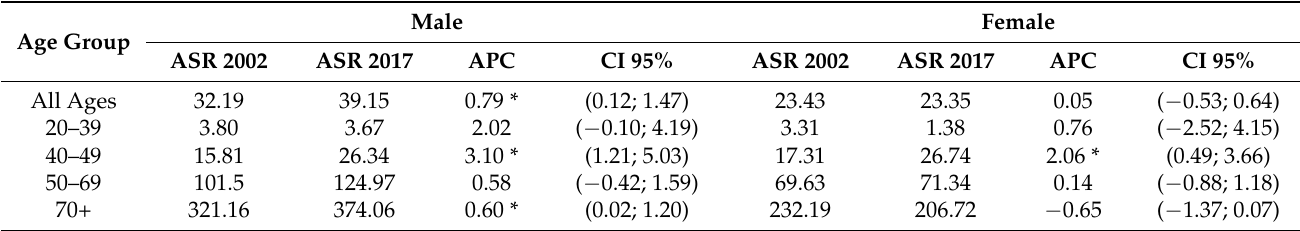
Table 2. Colorectal cancer incidence age standardized rates per 100,000 (ASR); annual percent change (APC) and 95% confidence interval (CI) by age group and sex, Uruguay, 2002–2017. Age